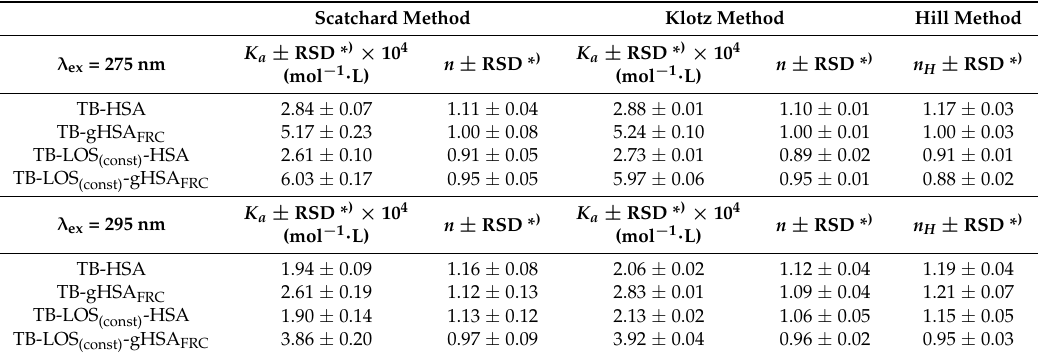
Table 5. Association constants K a (mol − 1 · L), mean number of TB molecule bound with one molecule of HSA and gHSA FRC ( n ) , the Hill’s coefficient ( n H ) in the binary (TB-HSA, TB-gHSA FRC ) and